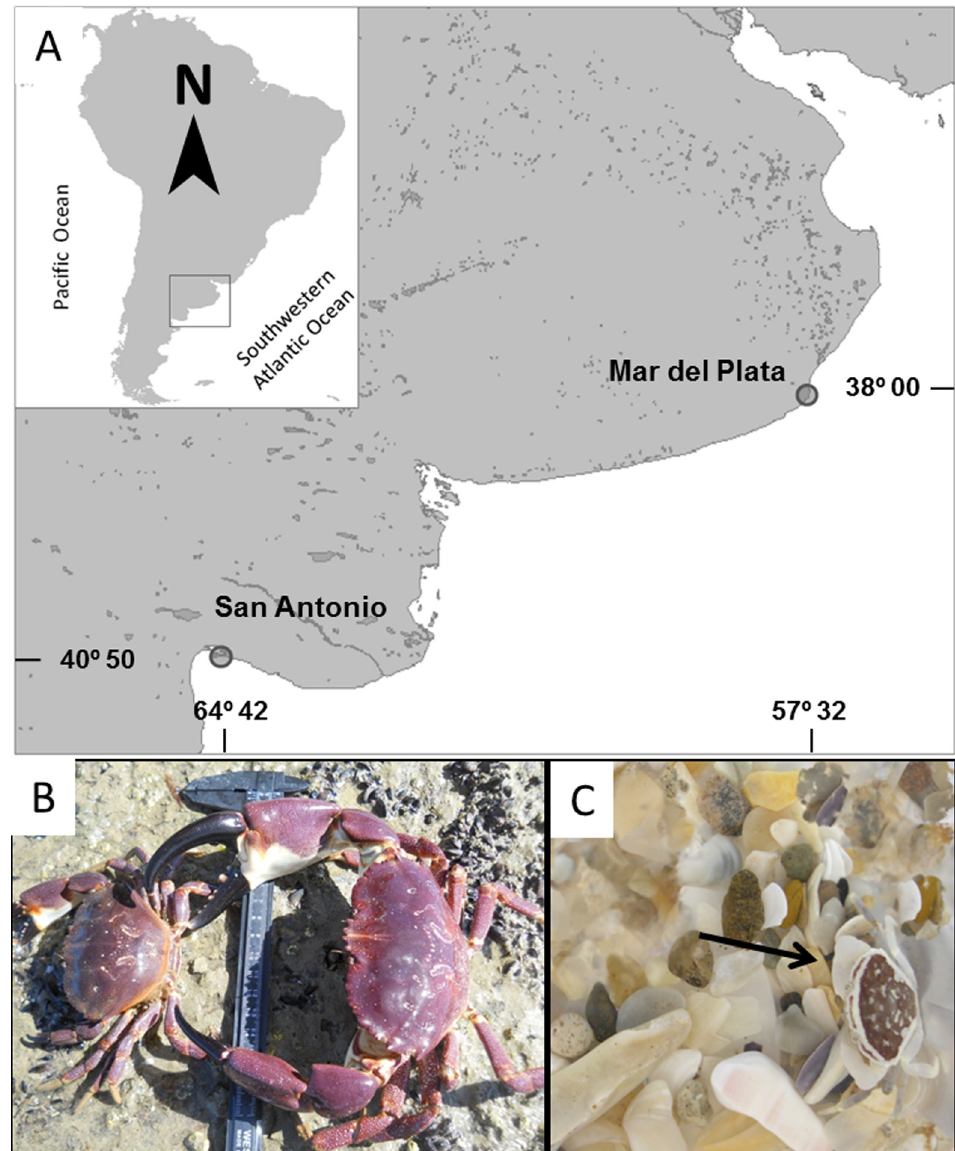
Fig. 1. – A, Sampling localities; B, members of a mating pair of Platyxanthus crenulatus (the smaller one is the female); C, a small juvenile showing the disruptive colour pattern against the broken shell bottom commonly found in intertidal